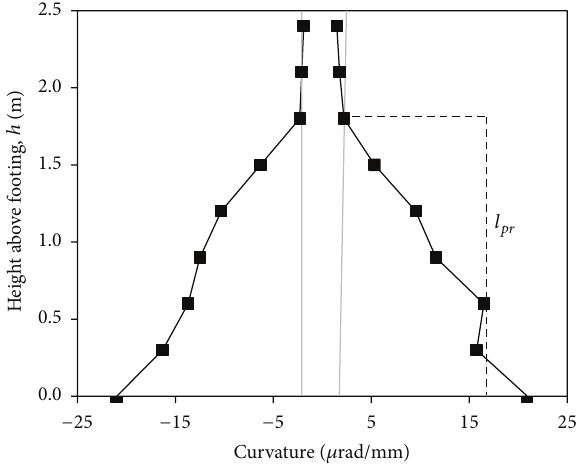
Figure 6: Specimen P4, curvature 𝜇 Δ = 3